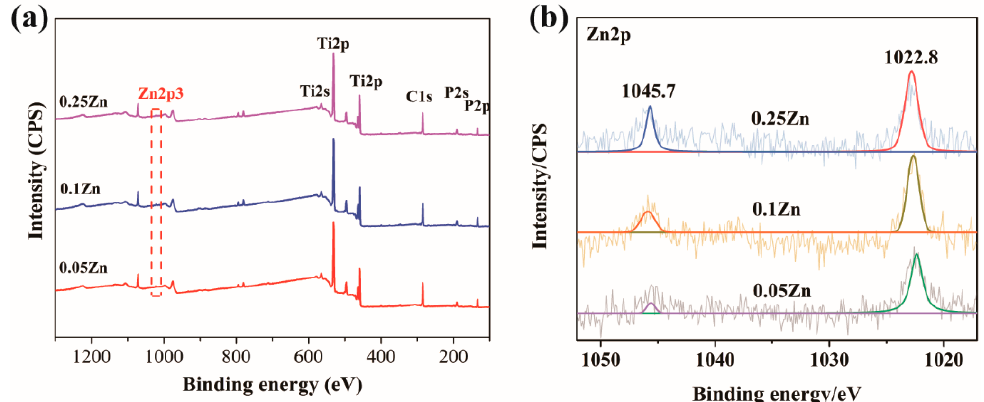
Figure 2. XPS survey spectrum ( a ) and Zn2p high-resolution spectra of the 0.05Zn-MAO, 0.1Zn-MAO and 0.25Zn-MAO coatings ( b ).